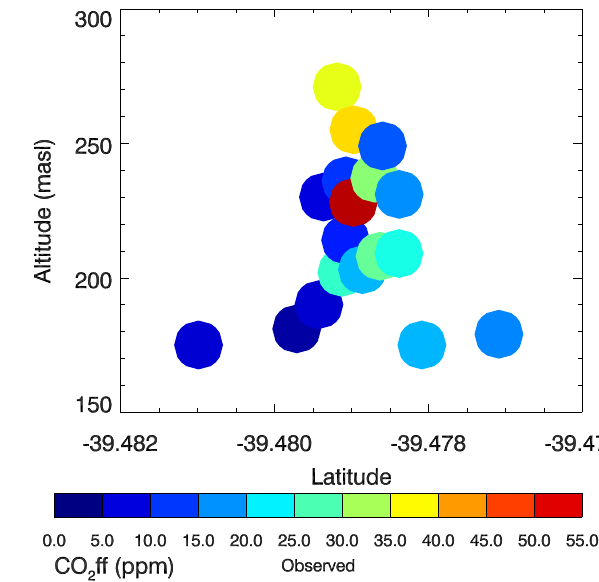
Figure 3. Measured CO 2 mole fraction as a function of altitude. Colors indicate the time of day.